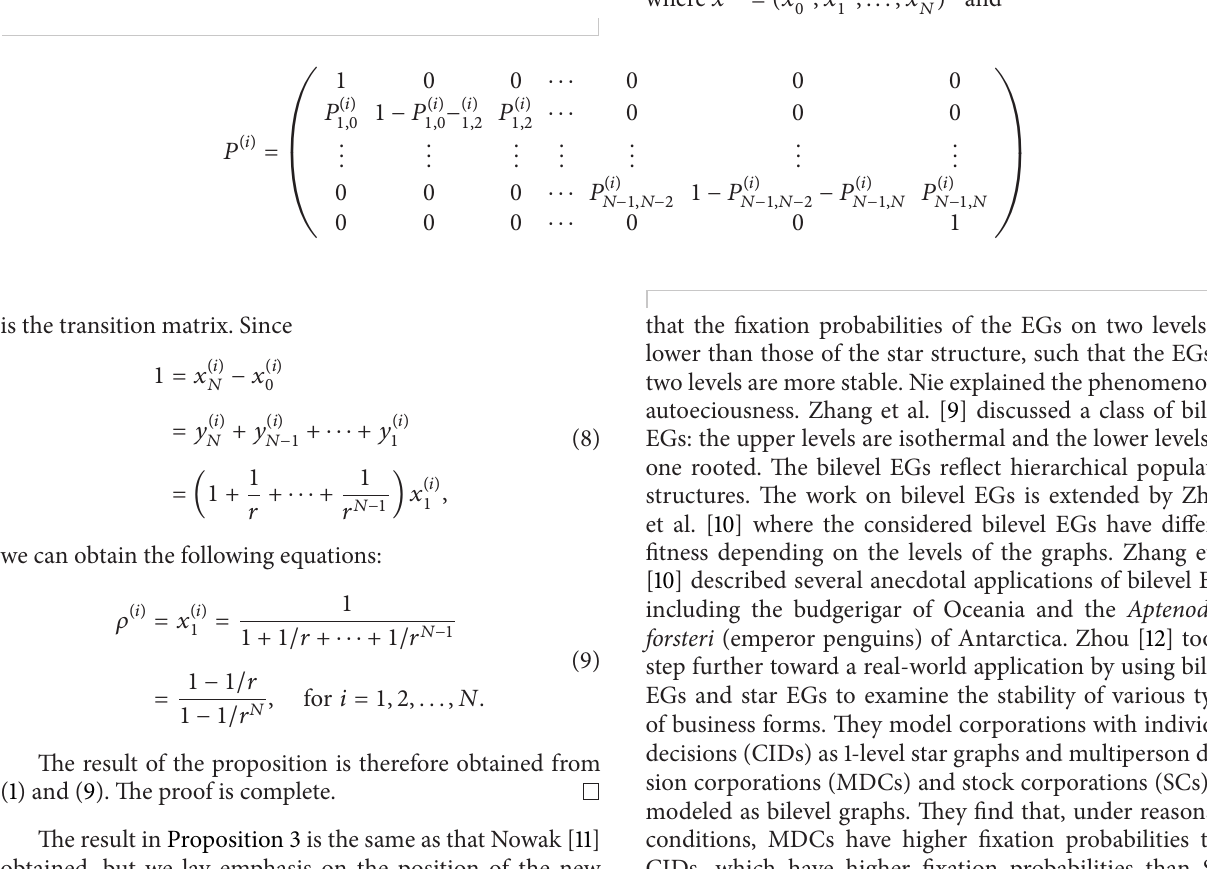
Figure 1: A directed circle with 𝑁